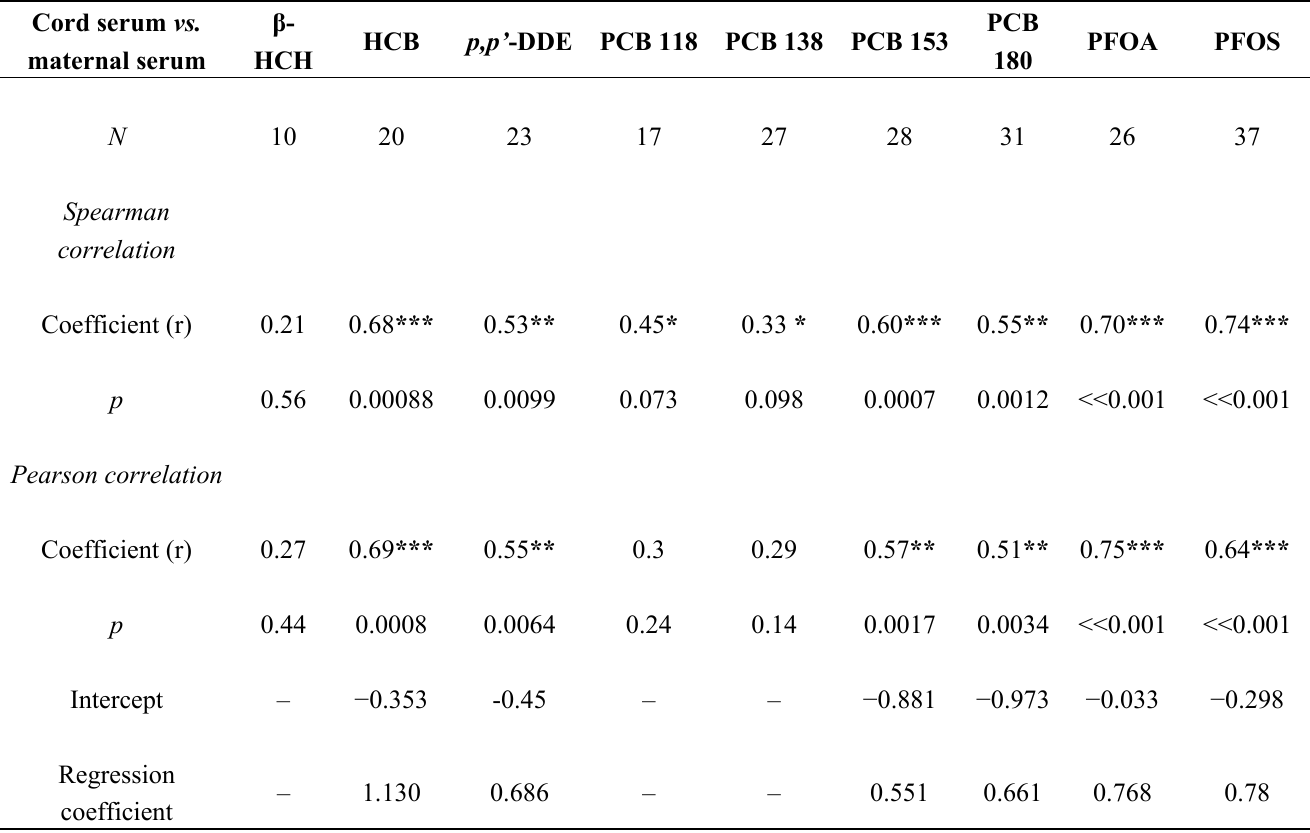
Table 3. Results from the Spearman and Pearson correlation analysis. Pearson regression was performed on log transformed